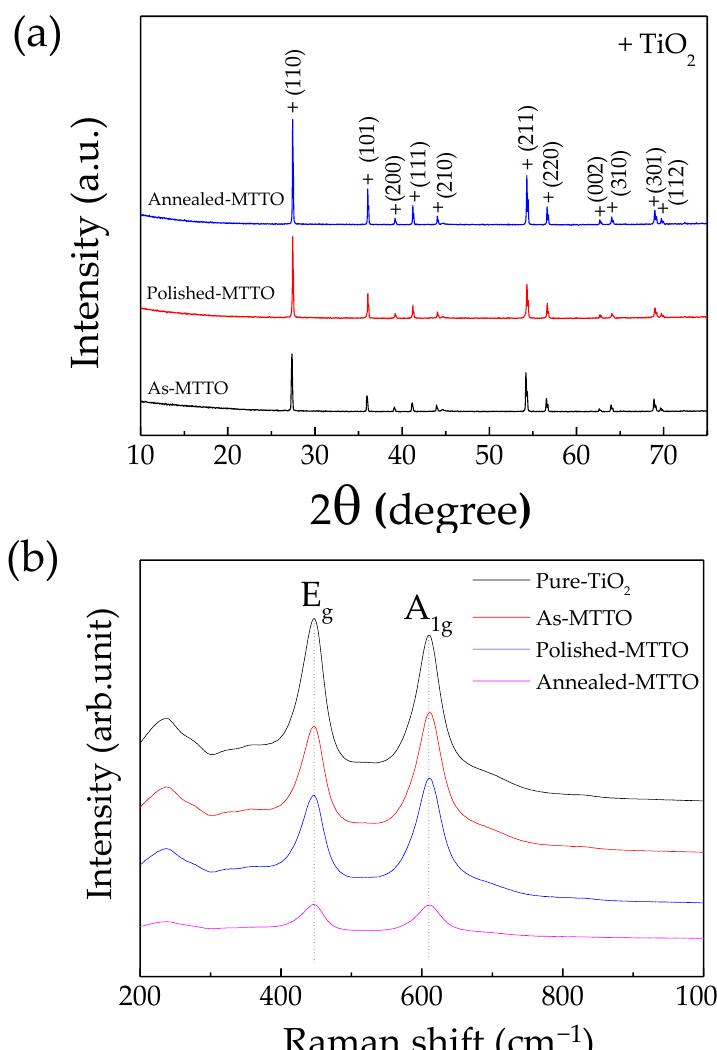
Figure 1. ( a ) XRD patterns of the as-MTTO, polished MTTO, and annealed MTTO ceramics sintered at 1400 °C for 2 h. ( b ) Raman spectra of the pure TiO 2 , as-MTTO, polished MTTO, and annealed MTTO ceramics.